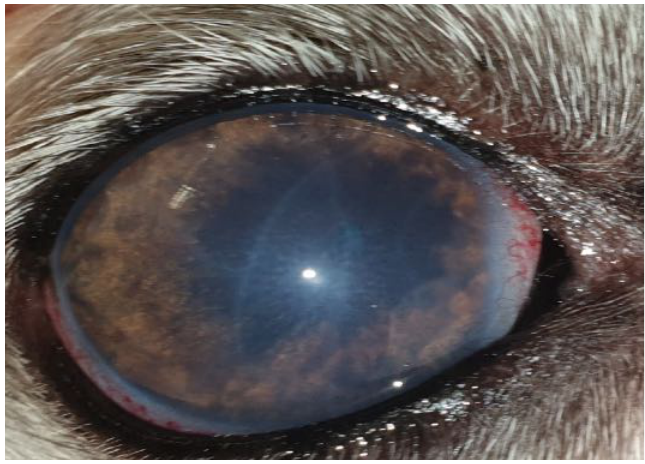
Figure 6. 6yo FN Whippet- Anterior uveitis and secondary chronic glaucoma- note the Haab’s striae (curvilinear grey/white lines across the cornea), the pupil was miotic owing to the recent application of latanoprost (North Downs Specialist Referrals)